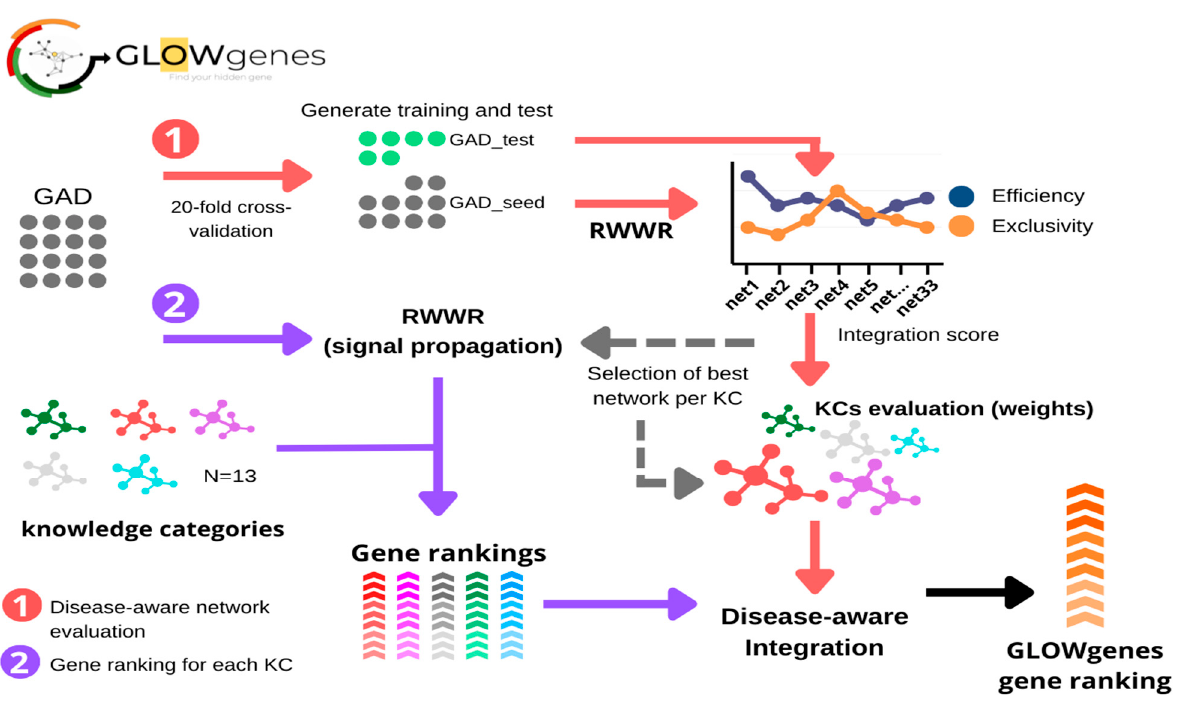
Figure 4. General schema of the GLOWgenes algorithm. GLOWgenes takes as input a set of genes associated with a disease (GAD) and performs two steps in parallel: (1) Step 1, the disease-aware network evaluation (red arrows), where GADs are randomly sorted into test (green dots) and training (grey dots). Efficiency (blue) and exclusivity (orange) are calculated for every knowledge category (KC) and an integration score is calculated. The integration scores merge efficiency and exclusivity obtained for the best performing KC network; (2) Step 2, gene ranking for each KC (purple arrows), where GADs are propagated in every best performing network (Step 1) using random walk with restart (RWWR) algorithm, producing a ranking of all genes for every KC (shown in different colors). KCs’ integration scores and KCs’ gene rankings are integrated into a GLOWgenes gene ranking as the KC performance-weighted average of normalized gene scores.